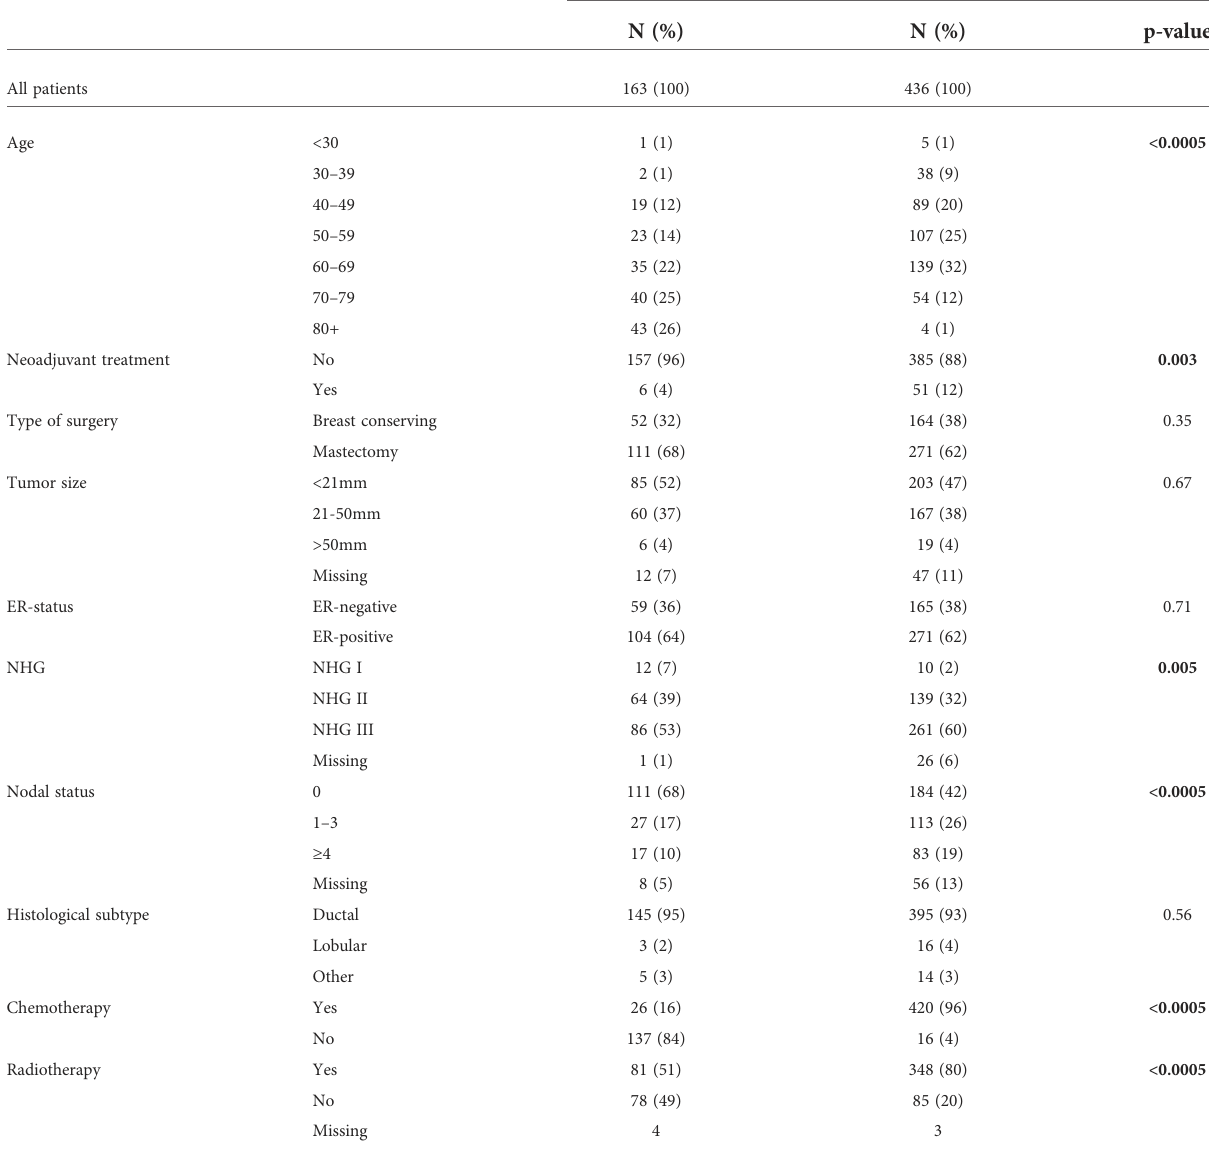
TABLE 1 Clinicopathological